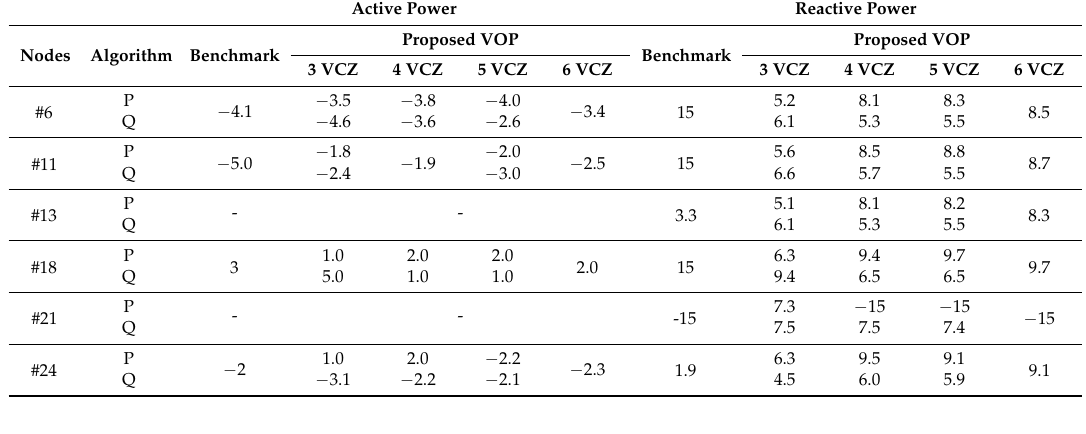
Table 11. Set-points P bess